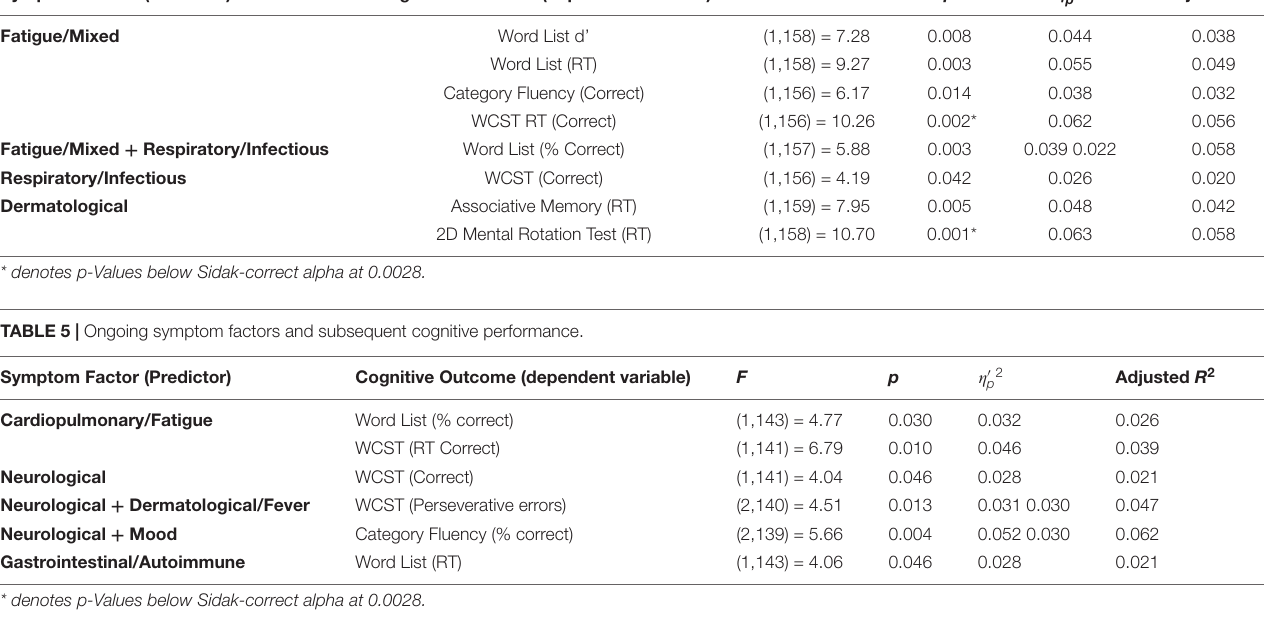
TABLE 4 | Initial symptom factors and subsequent cognitive performance. Symptom Factor (Predictor)